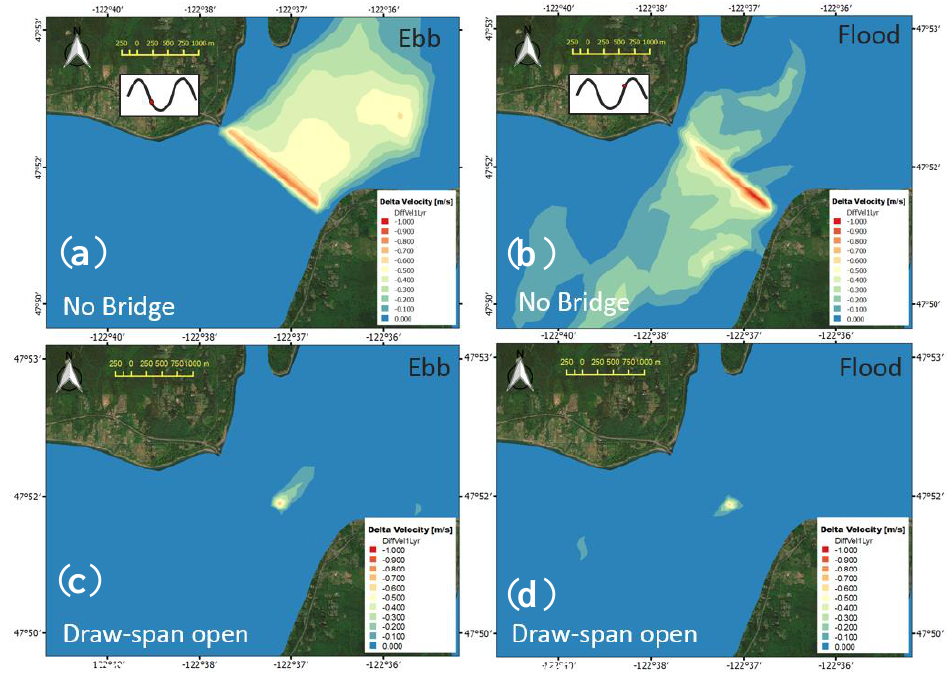
Figure 16. ( a , b ) Velocity difference of baseline scenario with HCB relative to test 1 without HCB during peak ebb and flood; ( c , d ) velocity difference of baseline scenario with HCB relative to test 2 with draw span open during ebb and flood. (Typical spring tide on 27 April 2017).